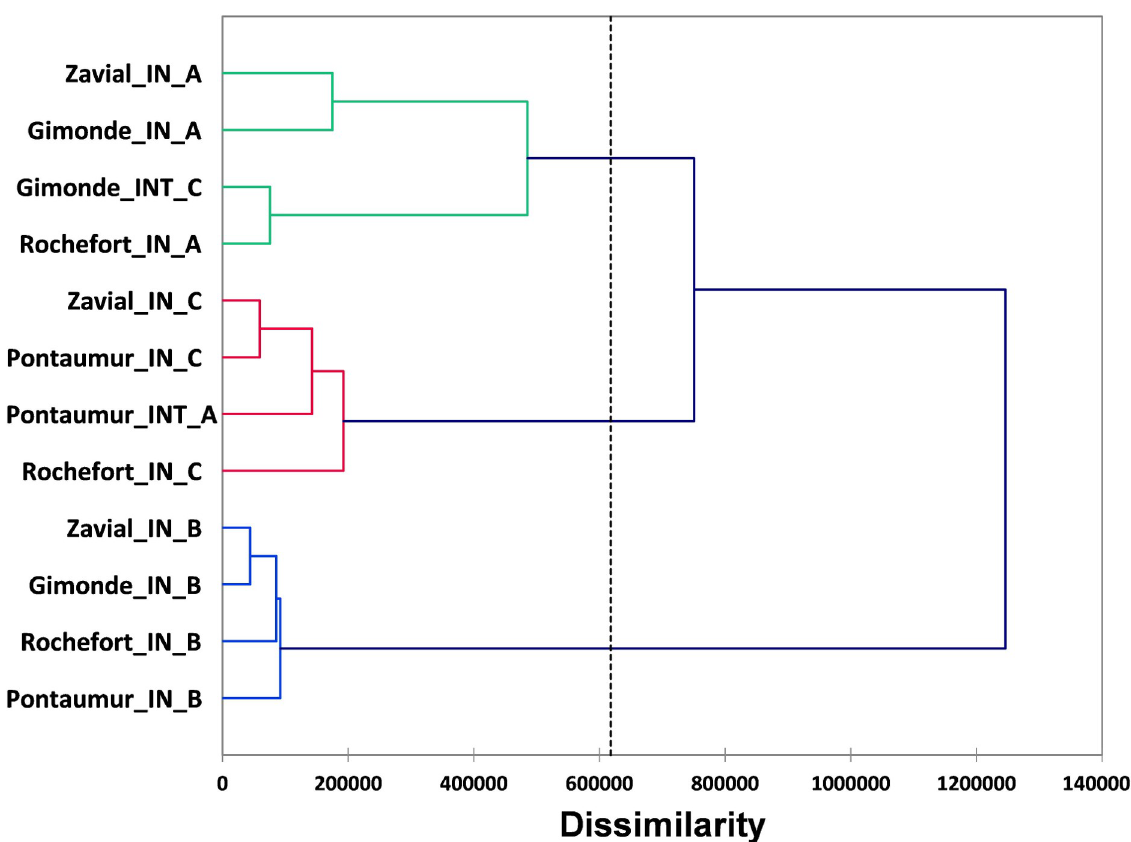
Fig 4. Dendrogram (distance measure: Euclidian; Linkage rule: Ward’s method) resulting of the hierarchical clustering analysis for RH levels measured in hives of the four conservation centers over a complete year for each iButton (A, B, C).